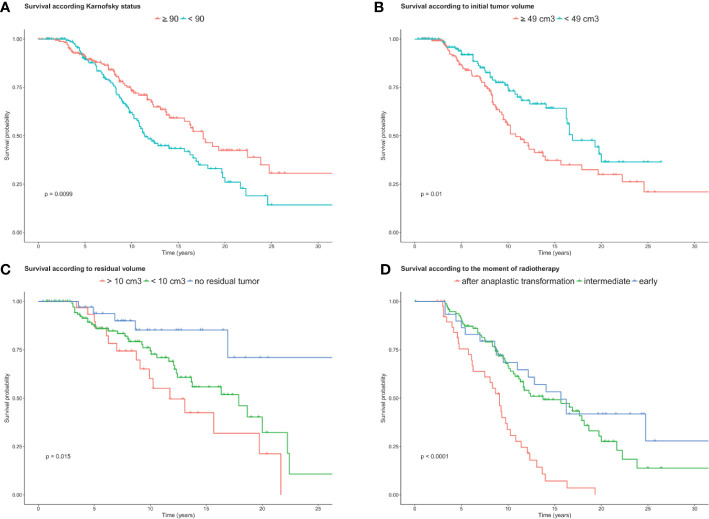
Overall survival curves. (A) Kaplan-Meier estimate curves showing the overall survival according to KPS (≤90 vs >90, n=339 patients). (B) Kaplan-Meier curves showing the overall survival according to the tumor volume at diagnosis (<49 cm3 vs. ≥49 cm3, n=339 patients). (C) Kaplan-Meier estimate curves according to postoperative residual volume (n=191 patients). (D) Kaplan-Meier estimate curves according to the moment of radiotherapy (n=167 patients).